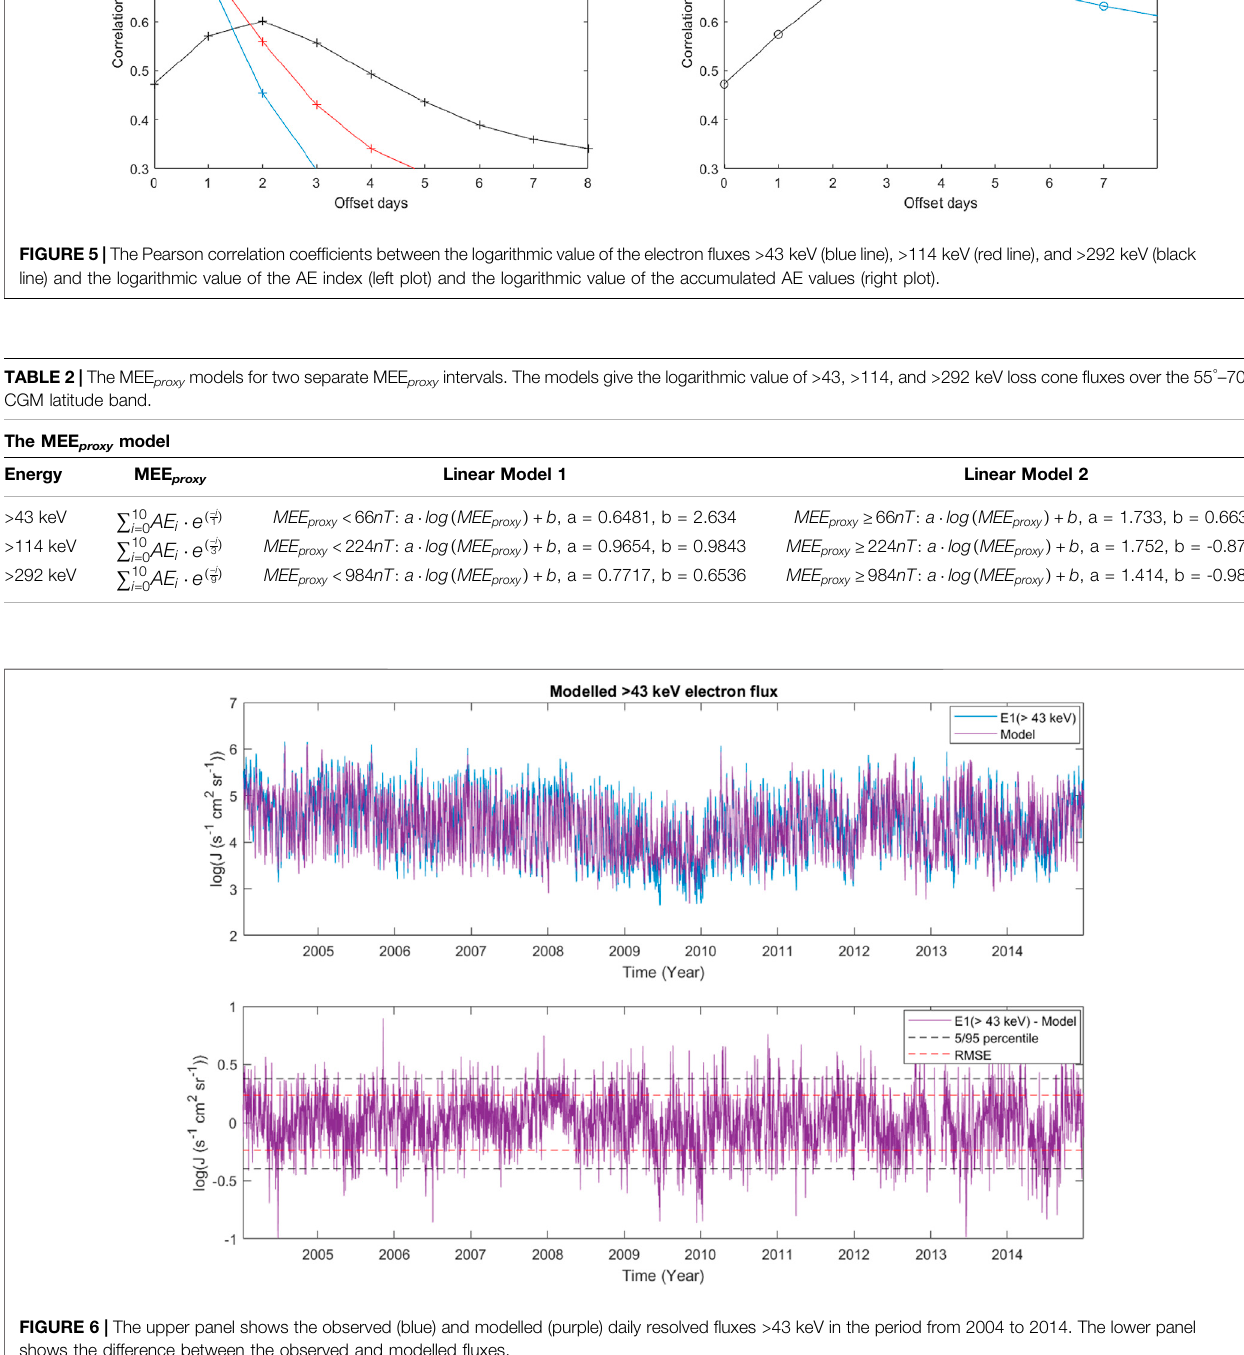
Frontiers in Astronomy and Space Sciences |